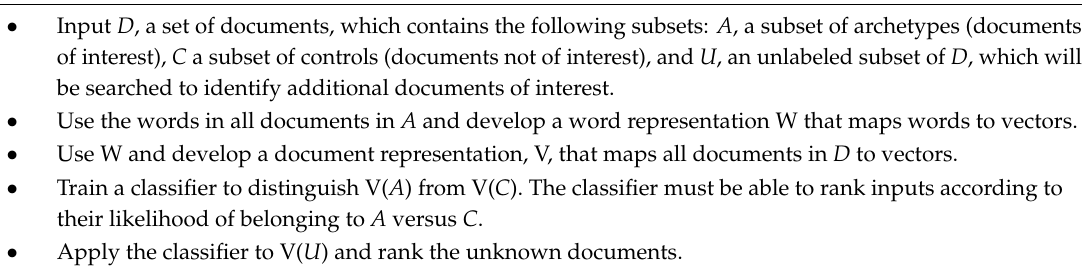
Algorithm 1 Archetype-Based Modeling and